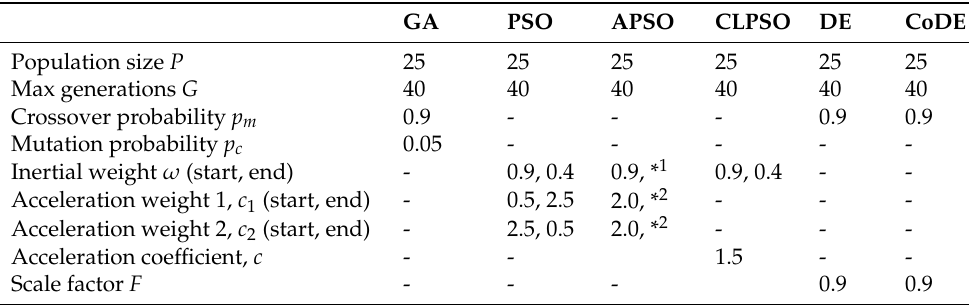
Table 3. Parameters for the evolutionary